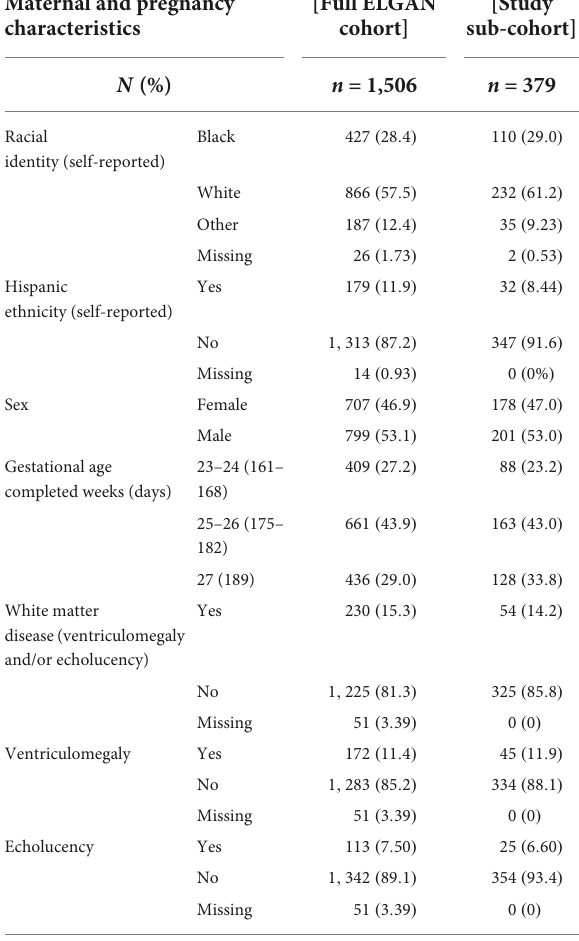
TABLE 1 Maternal demographics, pregnancy characteristics, and neonatal outcomes among study participants. Maternal and pregnancy